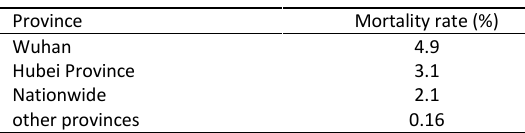
Fig. 3: Key advice for older adults and people with pre-existing conditions (WHO, 2020b) Table 1: Mortality rates due to COVID-19 as per the 3 rd February, 2020 (Worldometer, 2020)